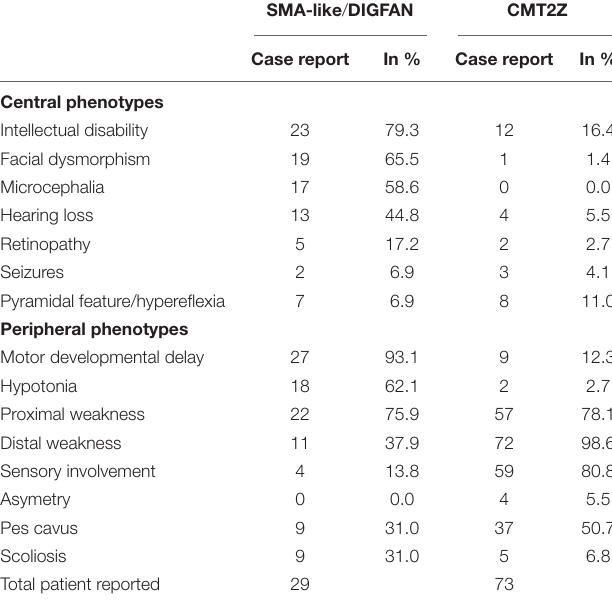
TABLE 2 | Summary of clinical characteristics of individuals with MORC2